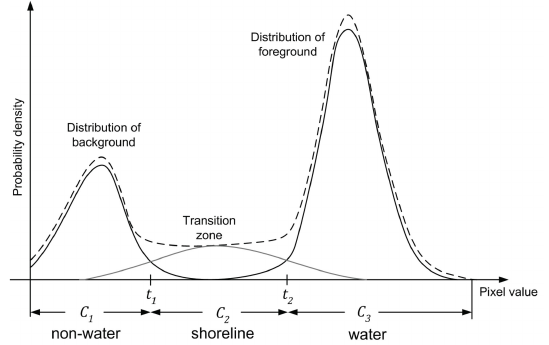
Figure 2. Density functions of shoreline object and related mixed Gaussian